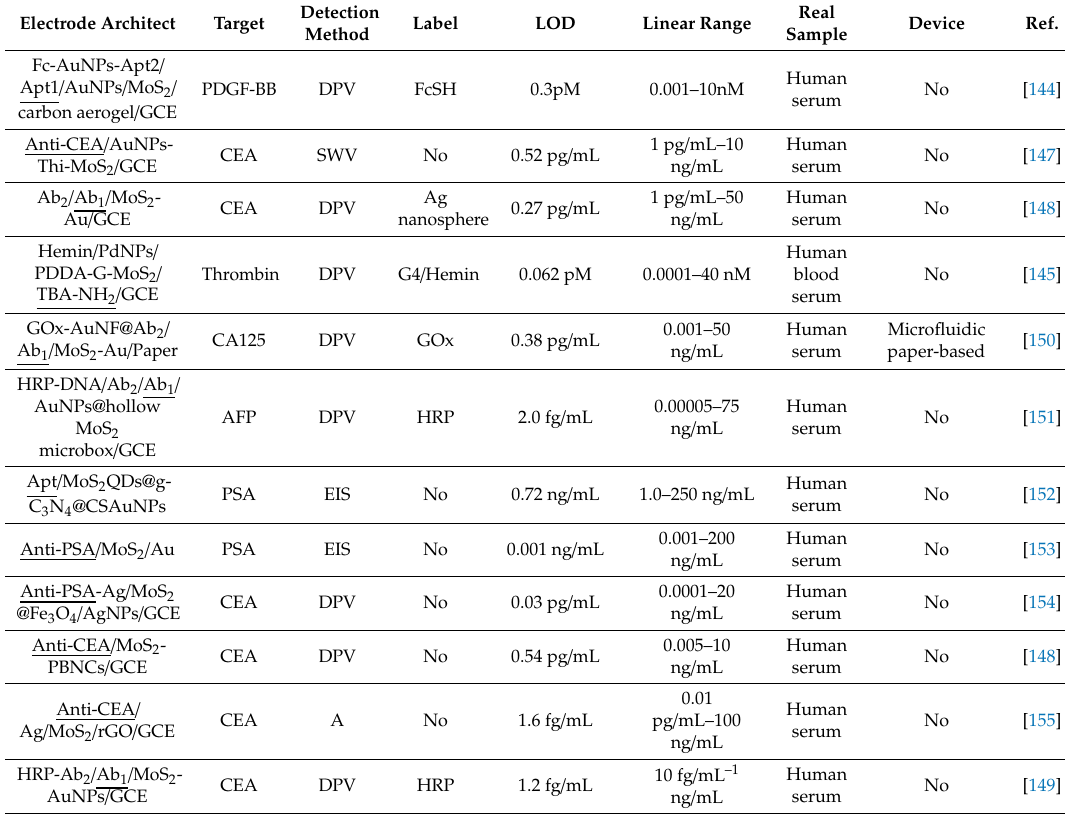
Table 5. MoS 2 -based electrochemical biosensors for protein cancer biomarkers quantification. The underlined terms are the